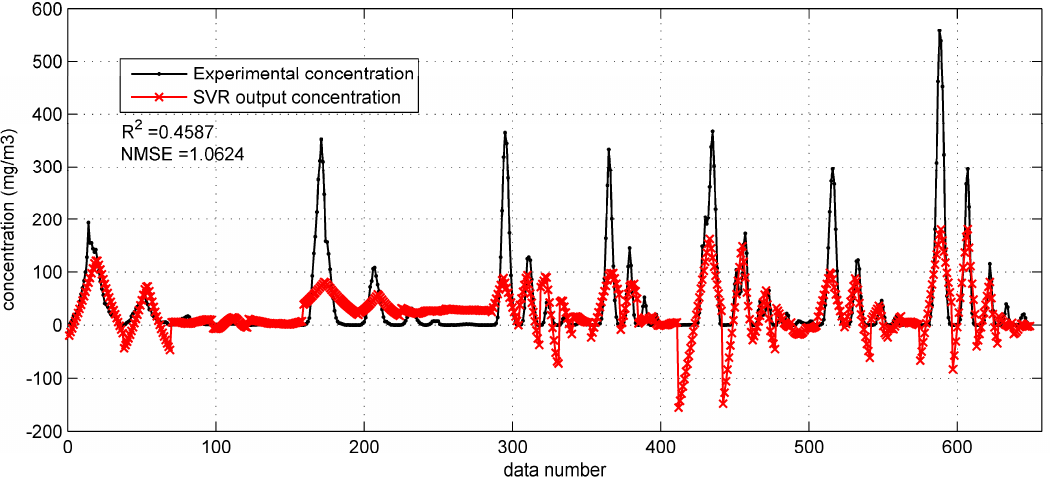
Figure 6. The prediction results of support vector regression (SVR) with original input parameters on the prairie Grass test set.